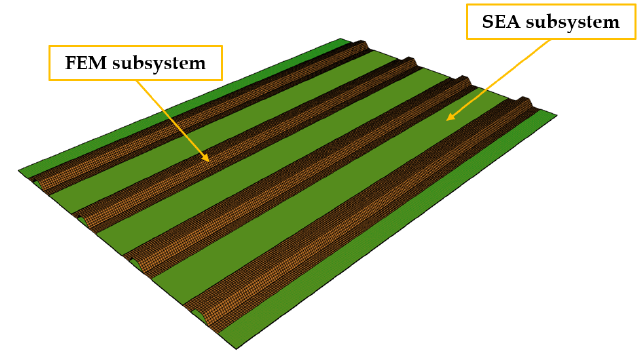
Figure 5. VAOne Hybrid FE-SEA